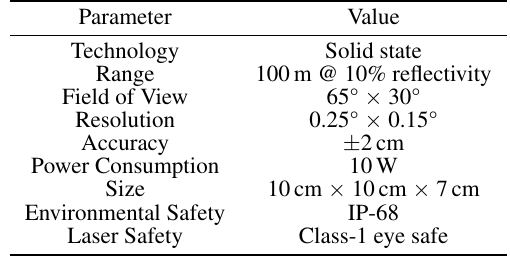
Table 1. Specifications of the sensor F-01